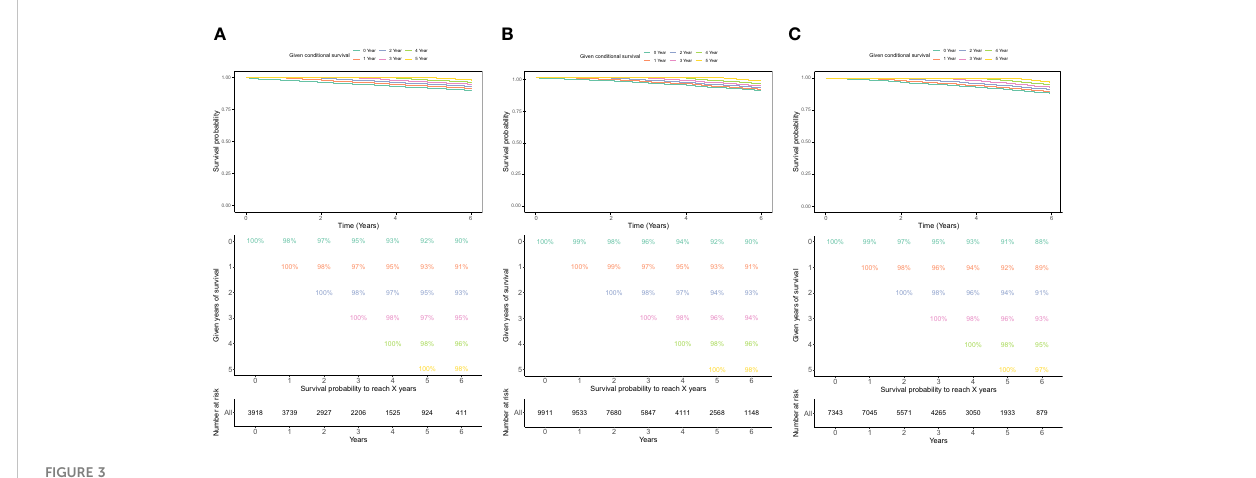
FIGURE 3 The conditional probability of survival of LONT ≥ 0.920 (A) , -0.586 ≤ LONT<0.920 (B) , and LONT<-0.586 (C)